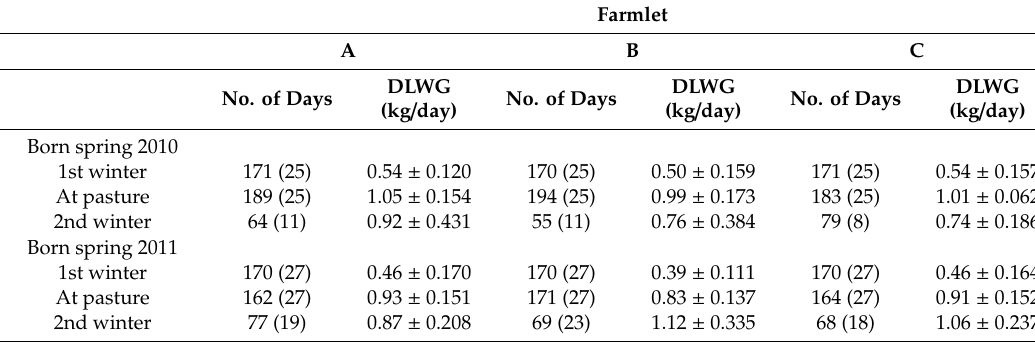
Table 7. Daily liveweight gain (DLWG) for cattle born in spring 2010 and 2011 when housed after weaning in their 1st winter; at pasture and then when housed again in their 2nd winter (numbers within parenthesis represent the number of animals present in each stage).